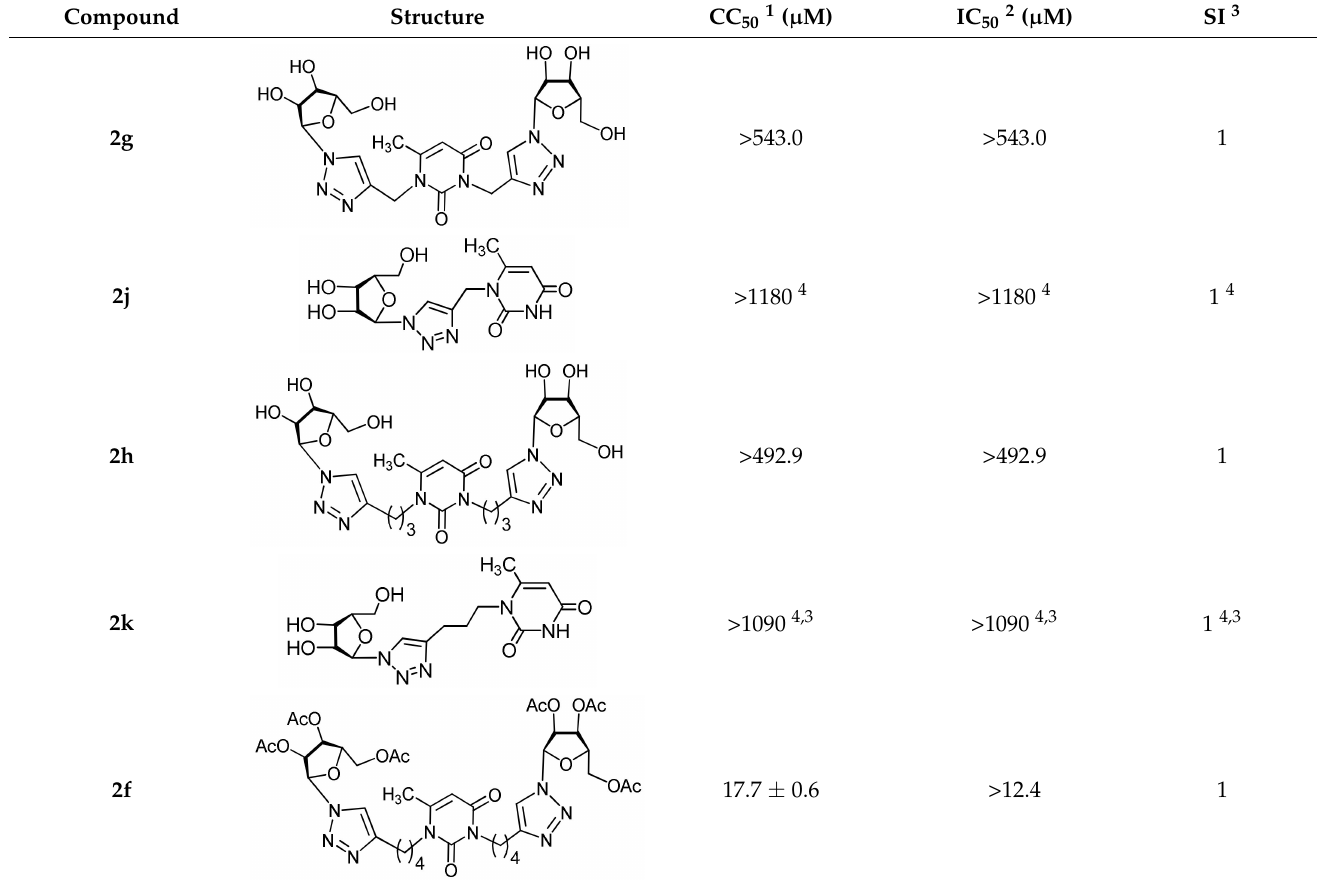
Table 2. Antiviral activity against the Coxsackie B3 virus and cytotoxicity of synthesized 1,2,3-triazolyl nucleoside analogues.